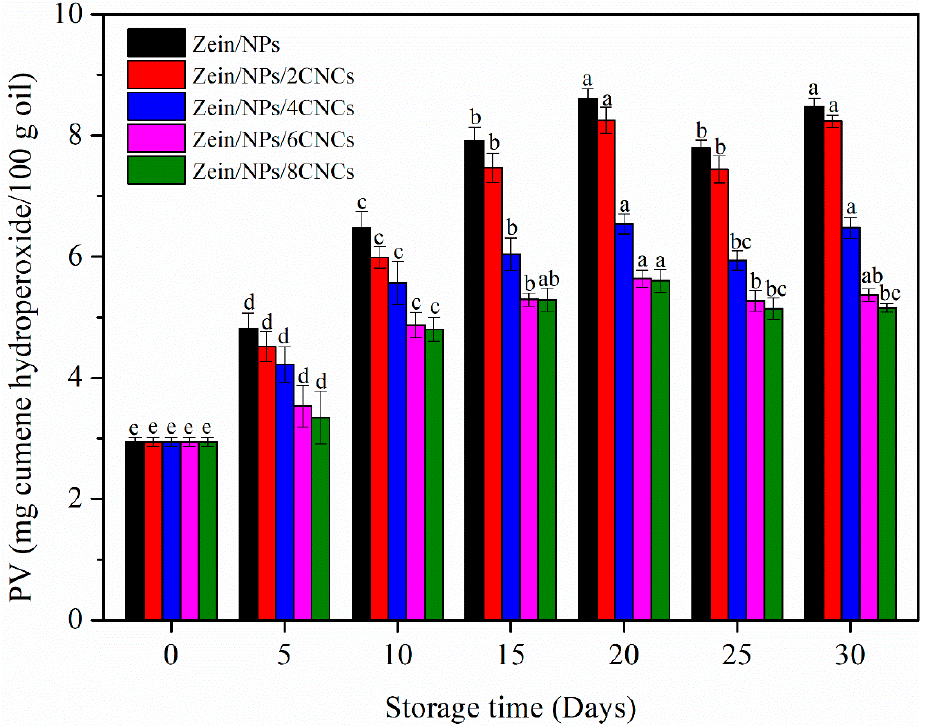
Figure 5. PV of oil packaged in Zein/NPs, Zein/NPs/2CNCs, Zein/NPs/4CNCs, Zein/NPs/6CNCs and Zein/NPs/8CNCs pouches. Different lowercase letters within the same packaging indicate significantly different as determined by Duncan’s test ( p < 0.05).